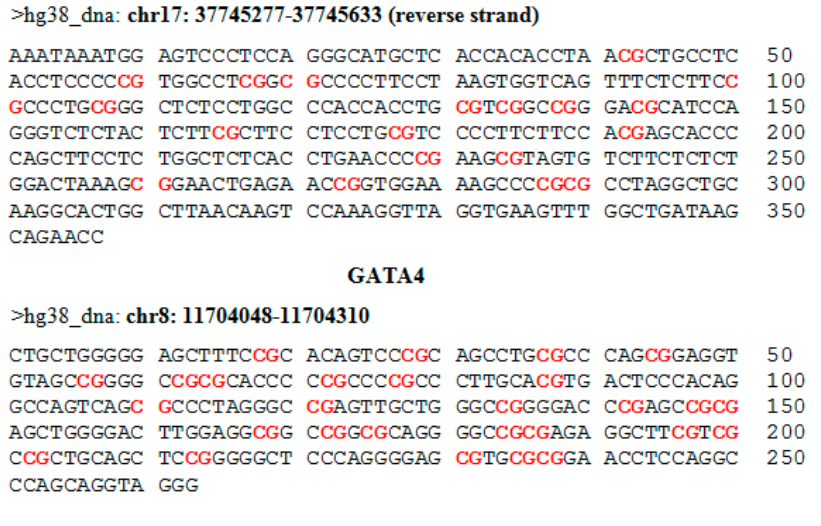
Figure A1. Genomic coordinates and analyzed CpG sites in HNF1B and GATA4 .